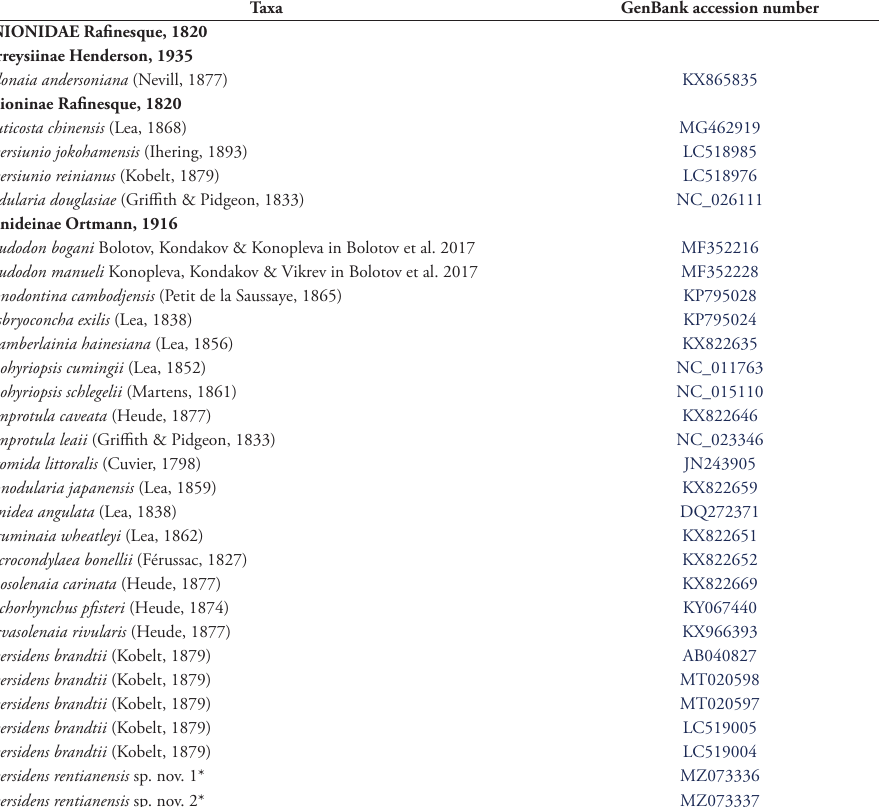
Table 1. List of sequences used in this study. (*) Sequenced from this study.